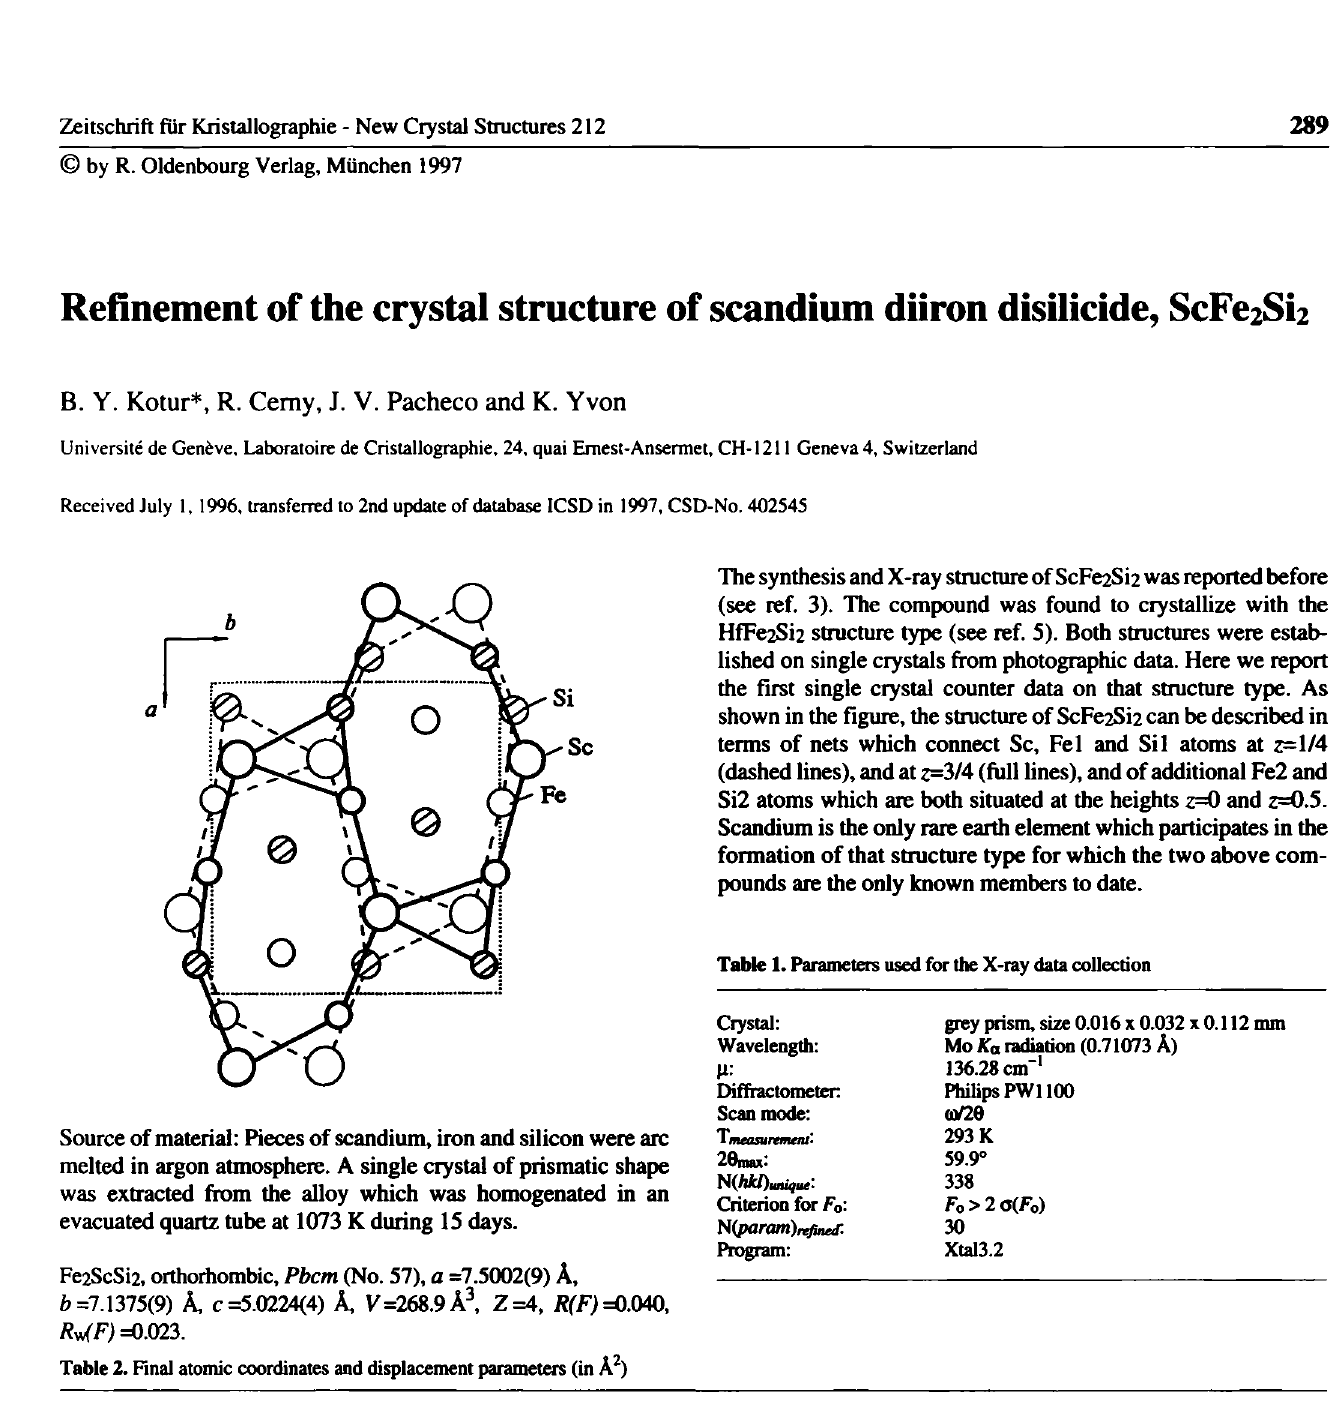
Table 2. Final atomic coordinates and displacement parameters (in Â 2 ) Atom Site